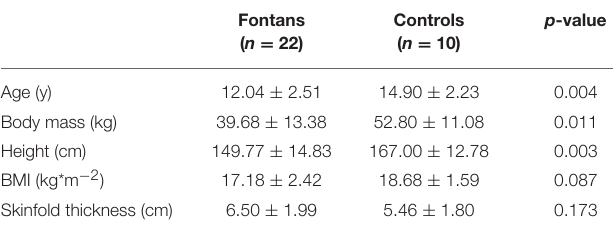
TABLE 1 | Characteristics of fontans and